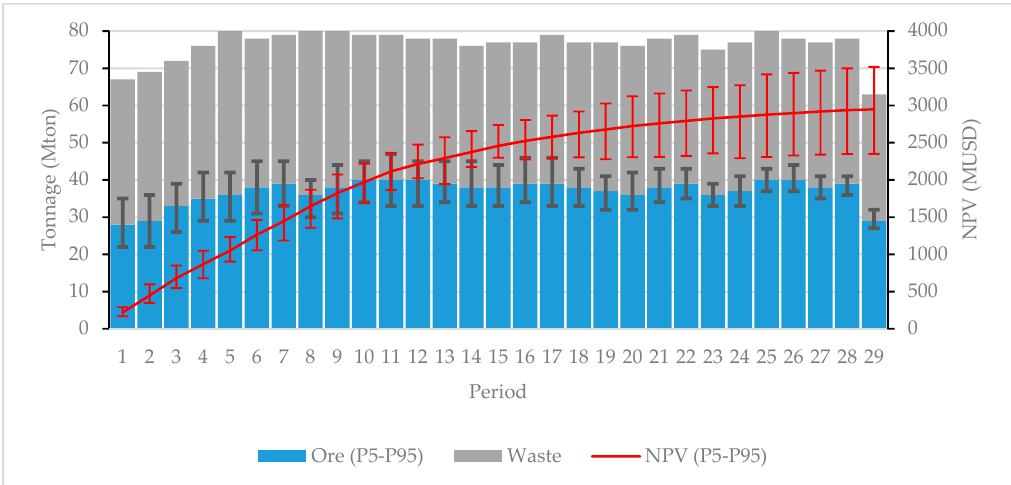
Figure 12. Ore and waste tonnages and net present value from production schedule obtained according (SCHED) by using scheduling Scheme 1. Results are assessed along all realizations into (STO) by using scheduling Scheme 3 for fair comparison.